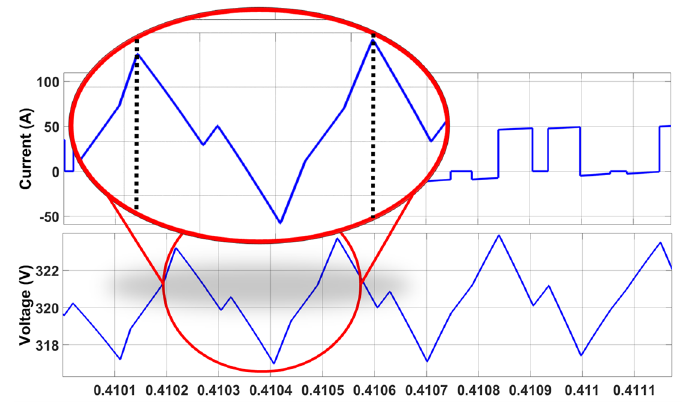
Figure 8. Inverter current zooming in on the critical case.